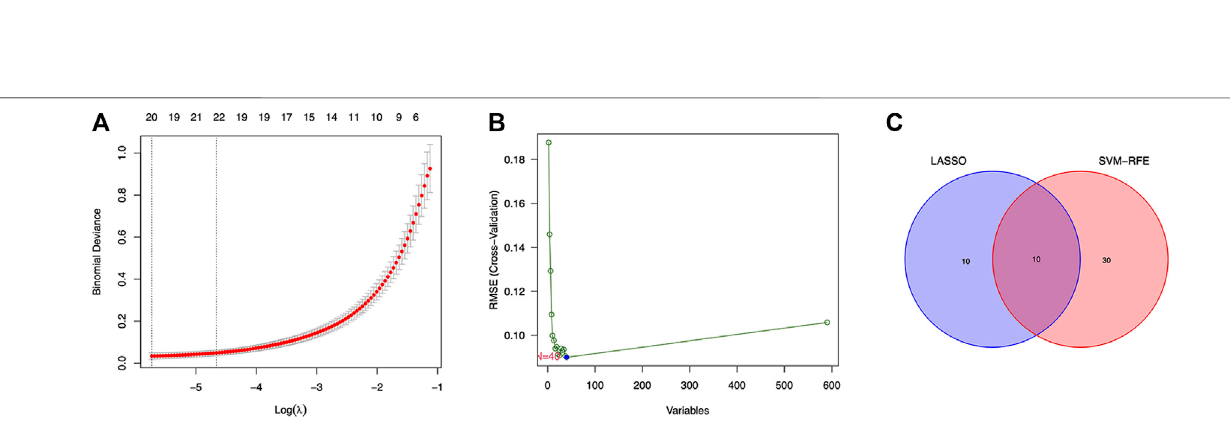
Frontiers in Genetics |